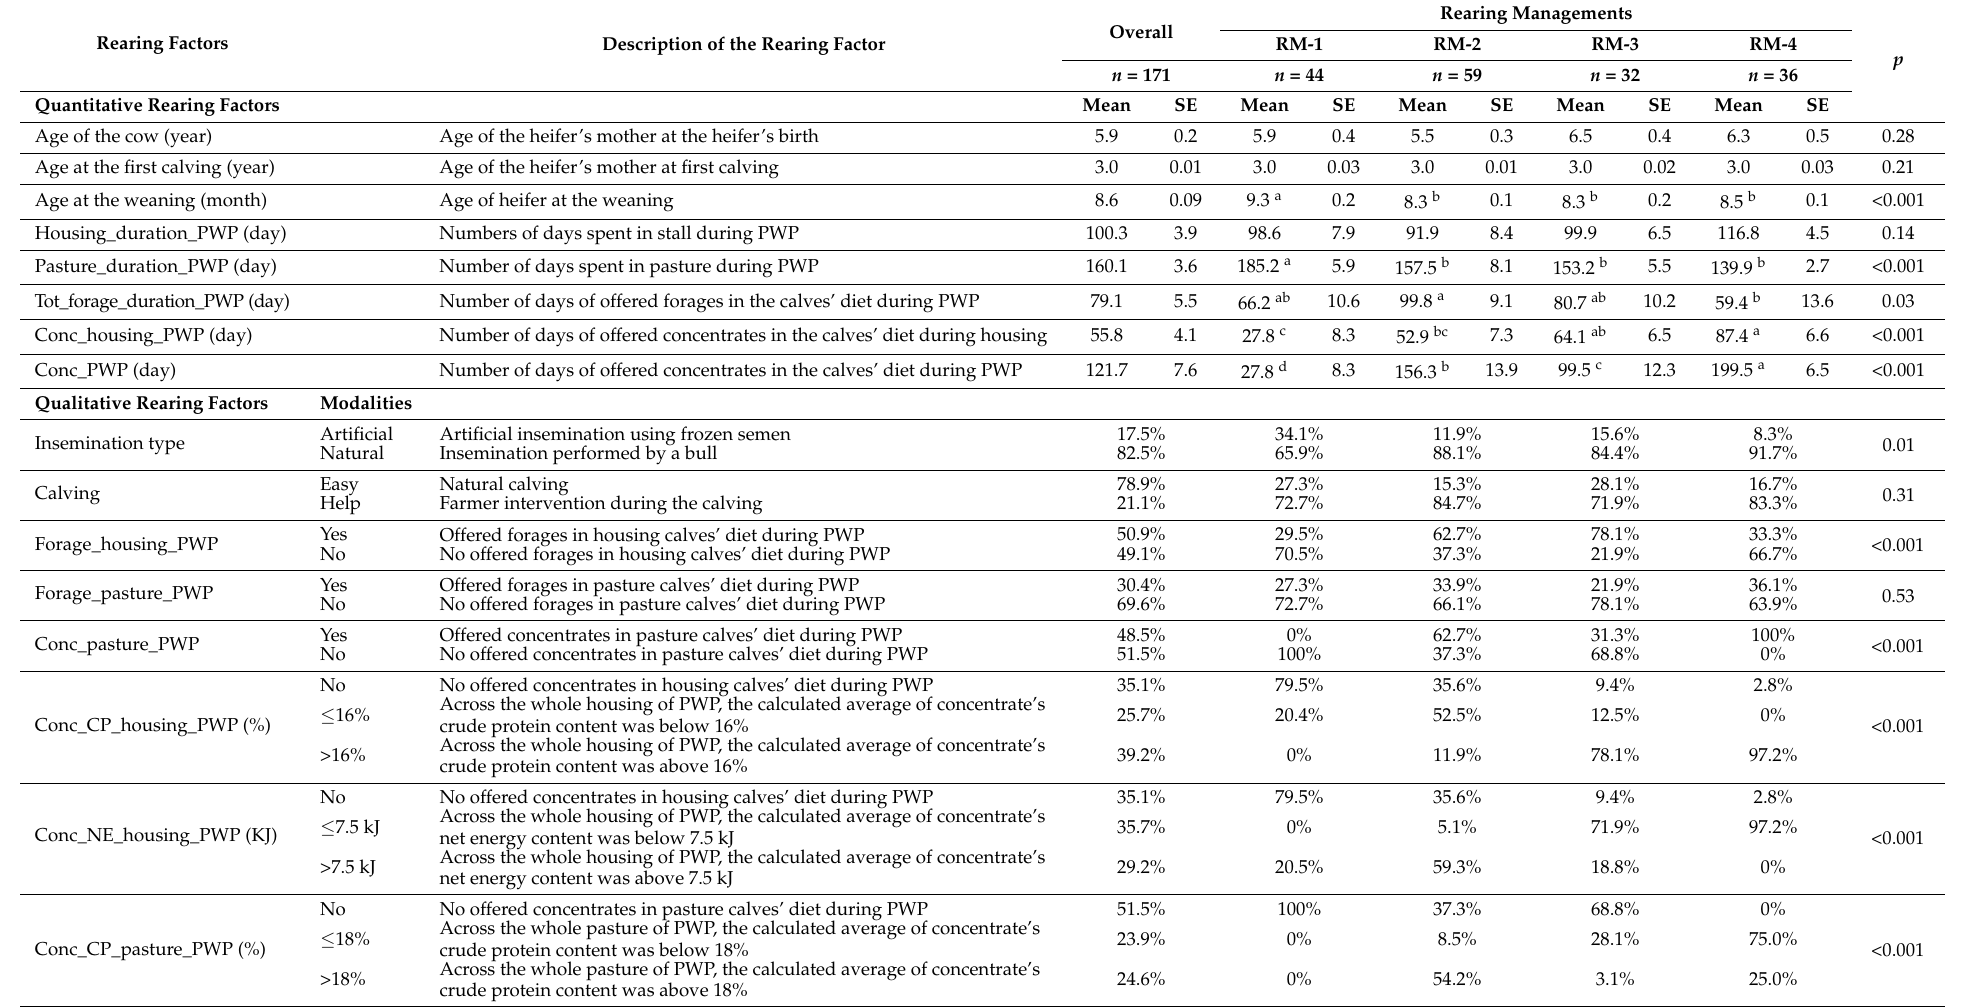
Table 1. Rearing factors characterizing the pre-weaning period (PWP) of the rearing managements (RM) applied during the heifers’ whole